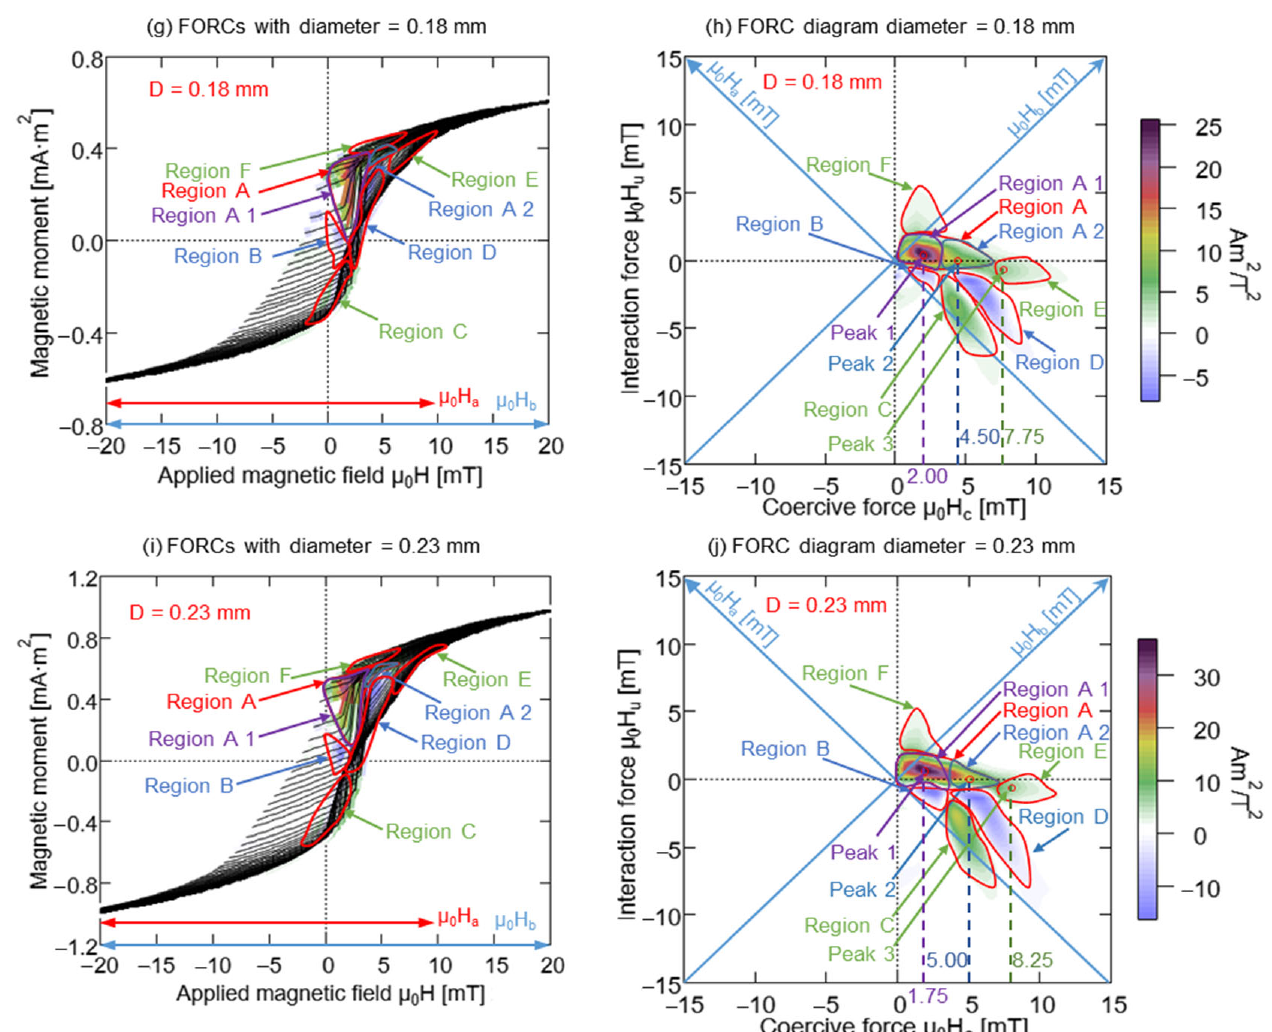
Figure 5. FORCs and FORC diagram of Wiegand wires with varying diameters.